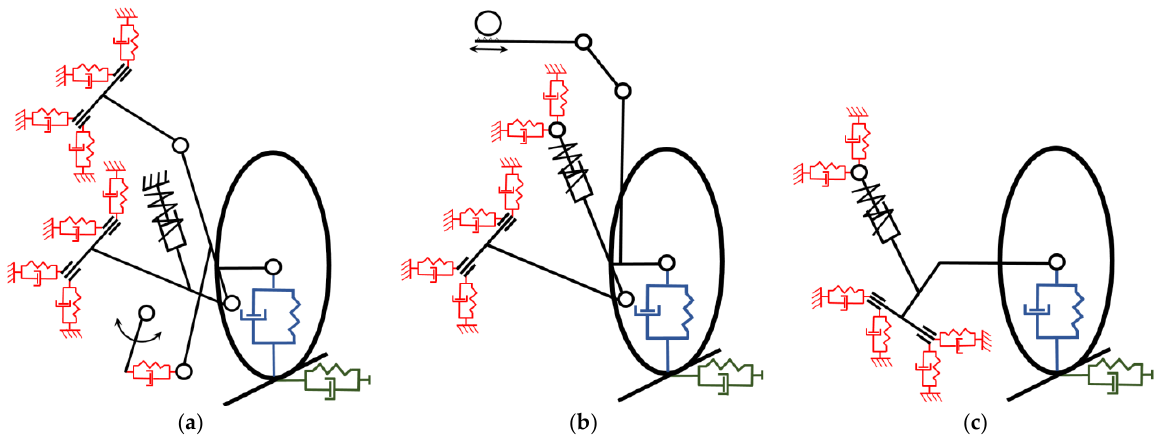
Figure 20. Kinematic schemes of the suspensions : ( a ) — double-arm suspension with lever steering mechanism; ( b ) — Mac- Pherson suspension with gear-rack type steering mechanism; ( c ) — semidependent single-arm suspension.